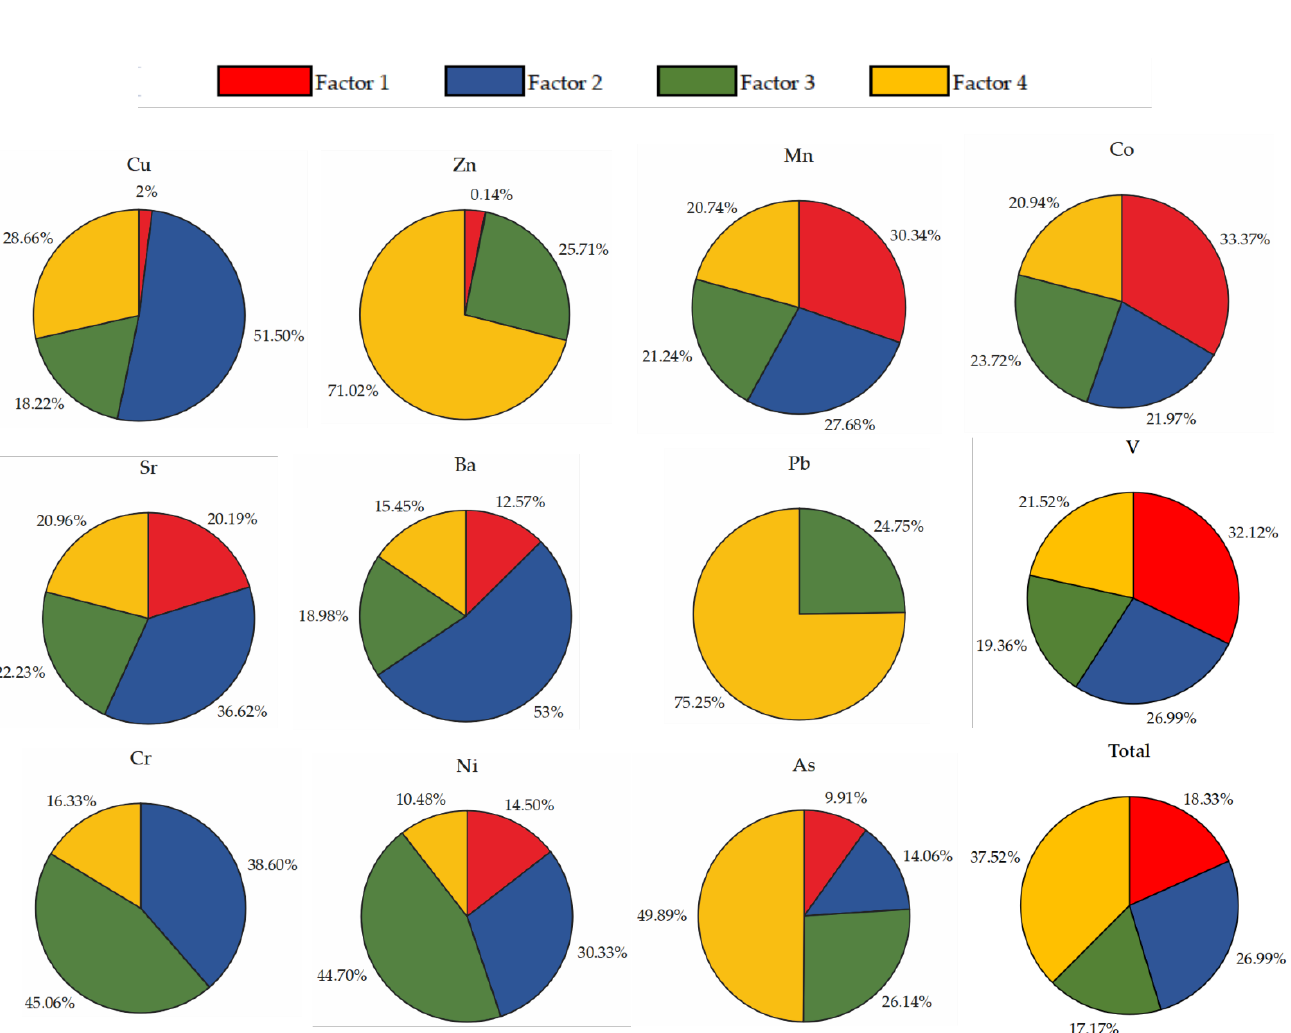
1 Note: * significantly correlated at p < 0.05; ** significantly correlated at p < 0.01. 4.2. The quantitative Source with the PMF In this paper, different pollution sources were tested in the PFM model. After import- ing the heavy metal concentrations data into the EPA PMF 5.0 software, the model was